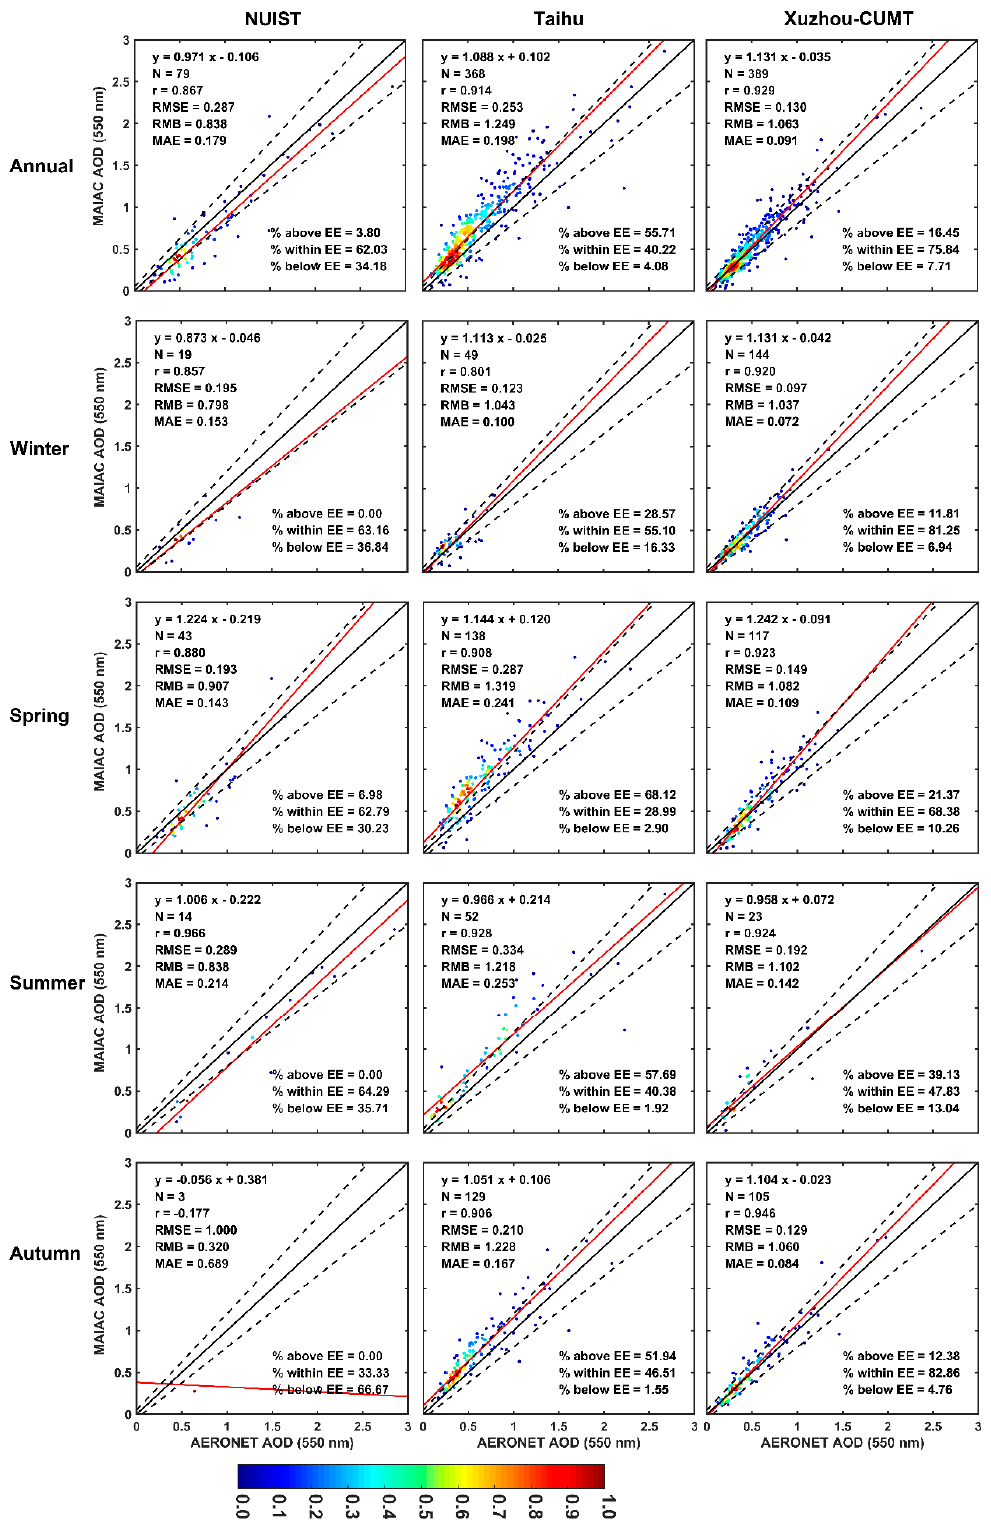
Figure 2. Evaluation of high-resolution (1 km) MODIS MAIAC AOD against AERONET AOD over NUIST, Taihu, and Xuzhou-CUMT sites located in Jiangsu Province from 2000–2020. The normalized data density is shown in color. The black solid line = 1:1, black dashed lines = EE lines, and red solid line = regression line.